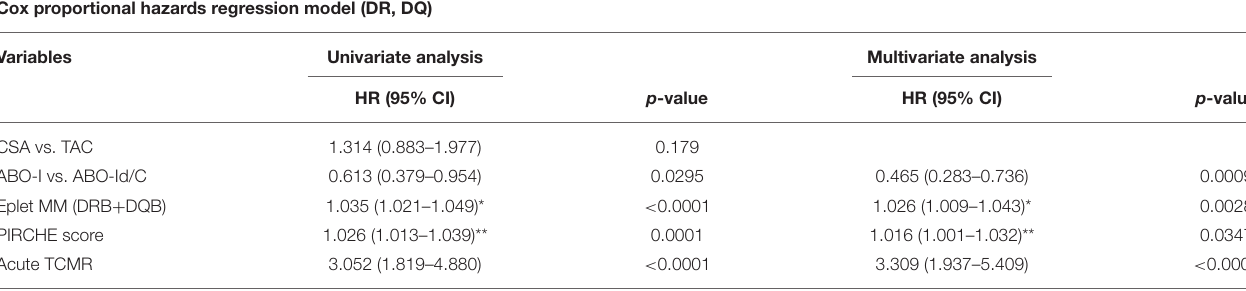
TABLE 3 | Risk factors associated with de novo DR/DQ DSA production. Cox proportional hazards regression model (DR,